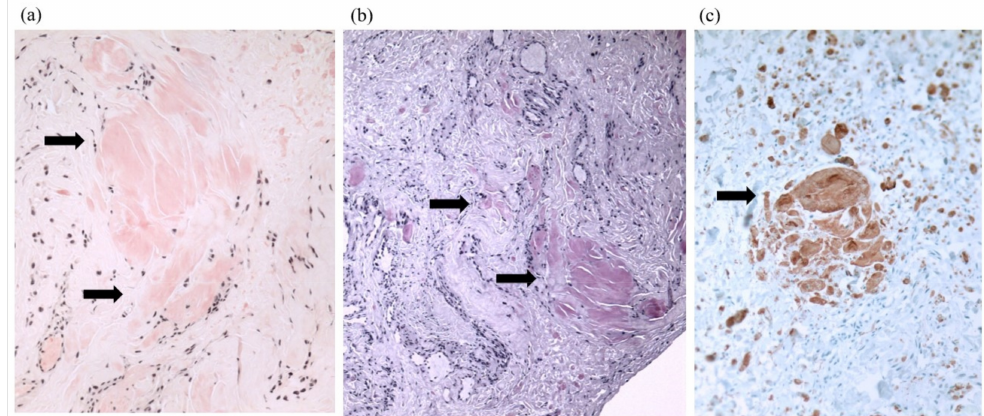
Figure 1. Congo Red stain ( a ), Sirius Red stain ( b ), and imunohistochemistry with anti-TTR ( c ). Arrows point amyloid (transthyretin) deposition in the flexor tenosynovium.